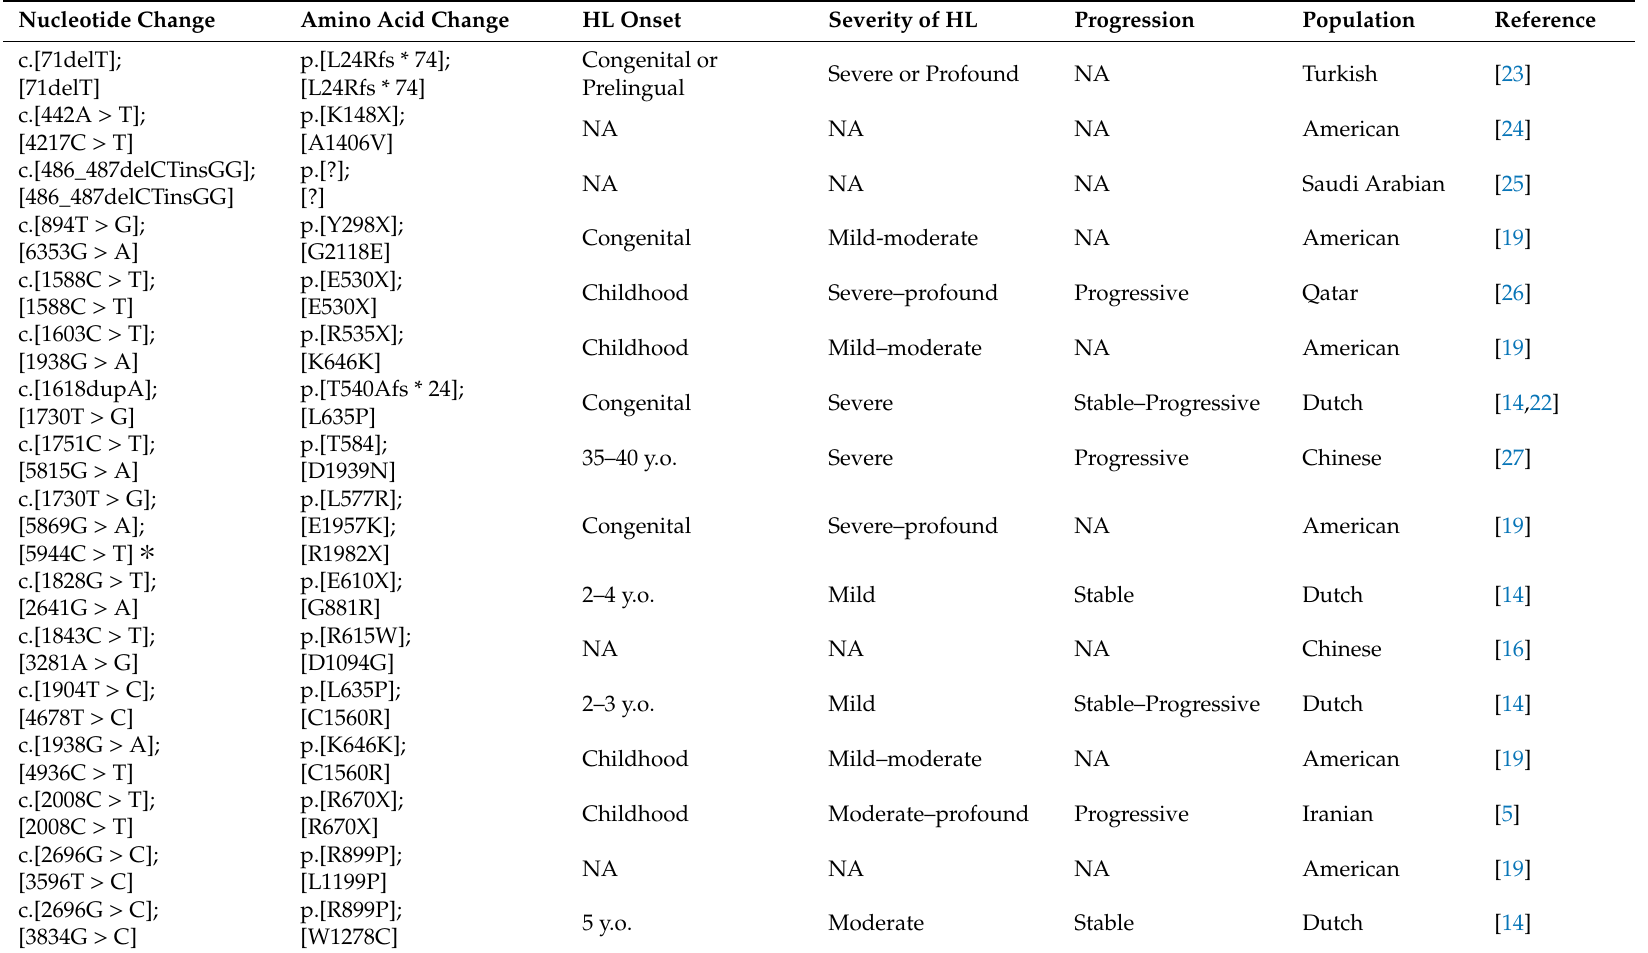
Table 3. All previously reported LOXHD1 gene variations and their clinical features (NM_144612).